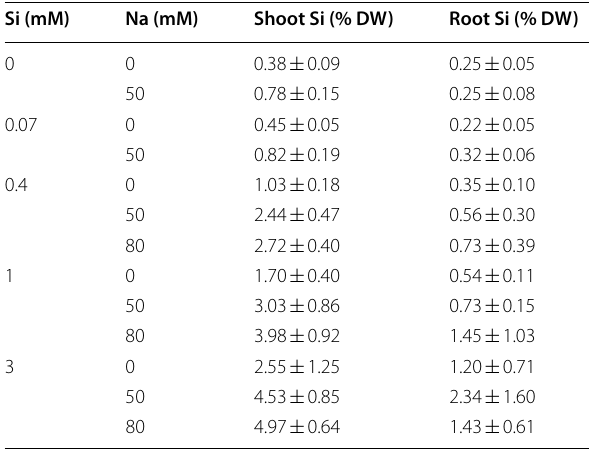
Si was measured in plants grown for 30 days in media with 0, 0.07, 0.4, 1 or 3 mM Si and 0, 50 or 80 mM